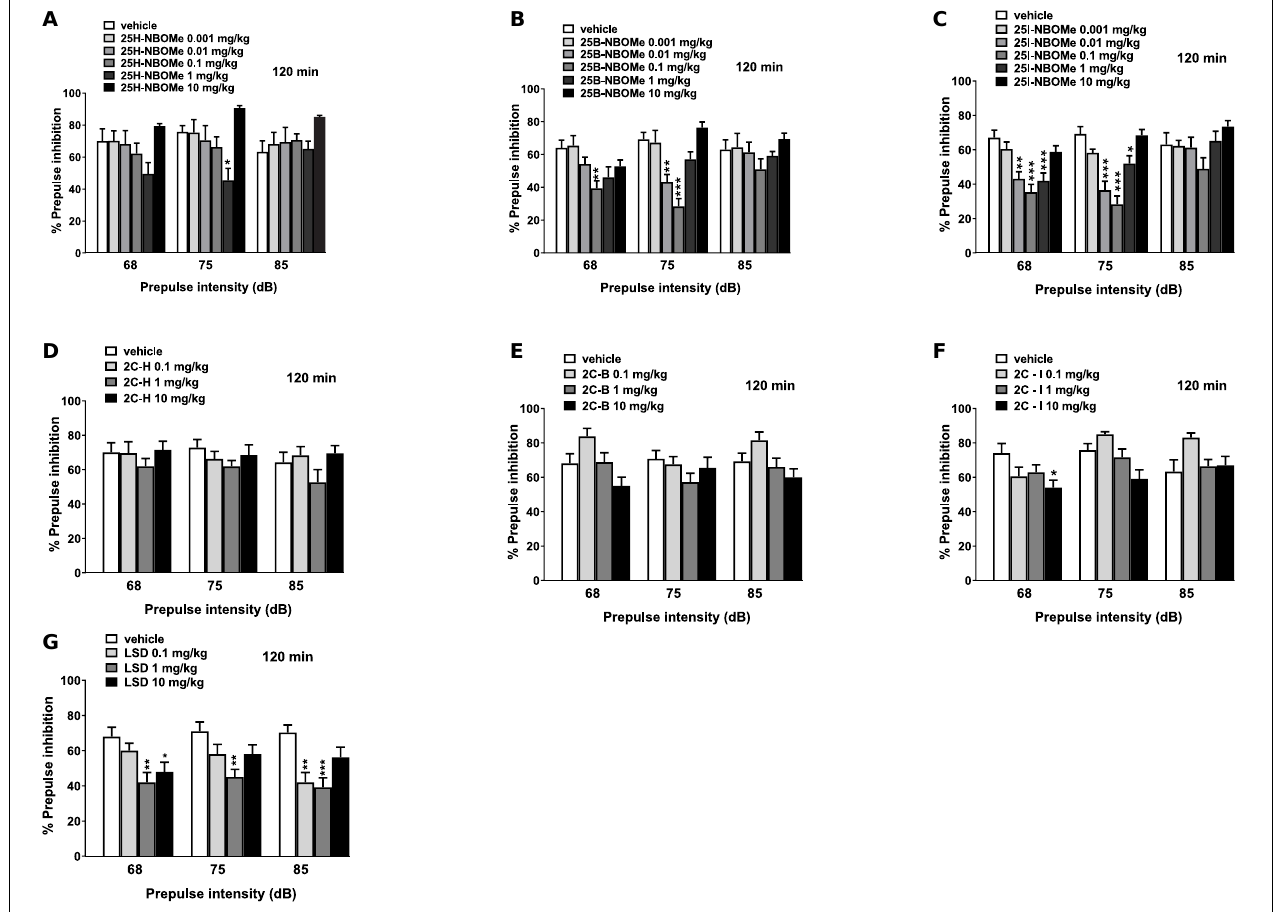
FIGURE 12 | Effect of 25H-NBOMe (0.001–10 mg/kg i.p.) (A) , 25B-NBOMe (0.001–10 mg/kg i.p.) (B) , 25I-NBOMe (0.001–10 mg/kg i.p.) (C) , 2C-H (0.1–10 mg/kg i.p.) (D) , 2C-I (0.1–10 mg/kg i.p.) (E) , 2C-B (0.1–10 mg/kg i.p.) (F) , and LSD (0.1–10 mg/kg i.p.) (G) on prepulse inhibition (PPI) in mice. Effects on PPI are shown for the three prepulse intensities (68, 75, and 85 dB) 120 min after treatment. PPI was expressed as the percentage decrease in the amplitude of the startle reactivity caused by presentation of the prepulse (% PPI; see section “Material and Methods”) and values represent mean ± SEM of 10 animals for each treatment. The statistical analysis was performed with a one-way ANOVA followed by Bonferroni’s test for multiple comparisons. * p < 0.05, ** p < 0.01 and *** p < 0.001 vs.